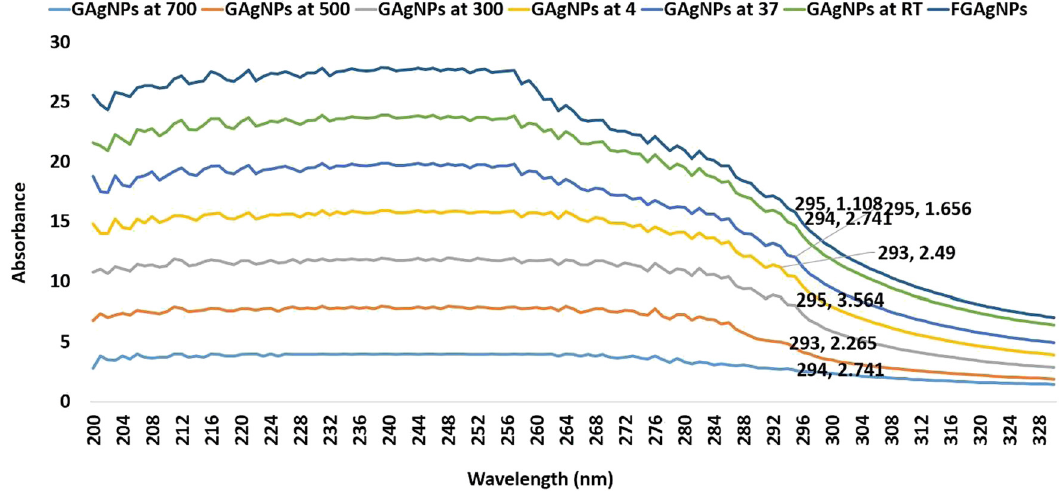
Figure 1: UV - Vis spectra analysis of green - synthesized silver nanoparticles using A. sativum clove